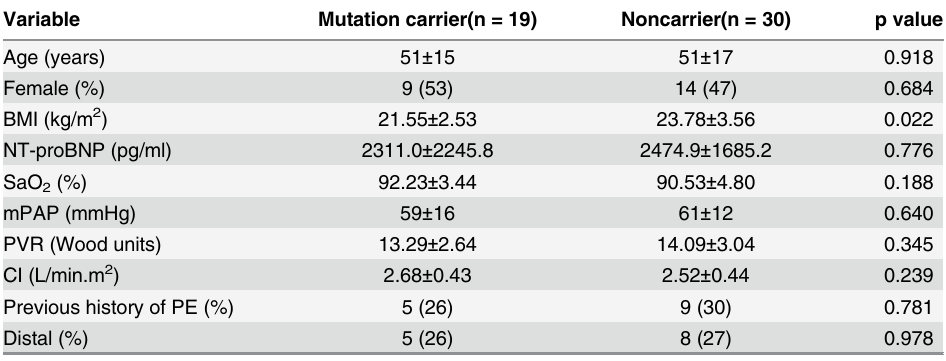
Table 7. Comparison of clinical characteristics of CTEPH patients in nonsynonymous mutation carri- ers and